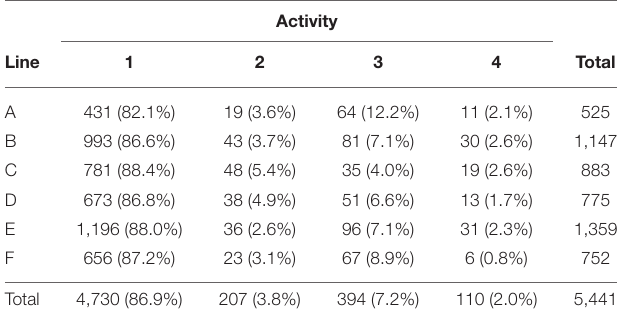
Numbers in brackets refer to percent of birds per score within each genetic